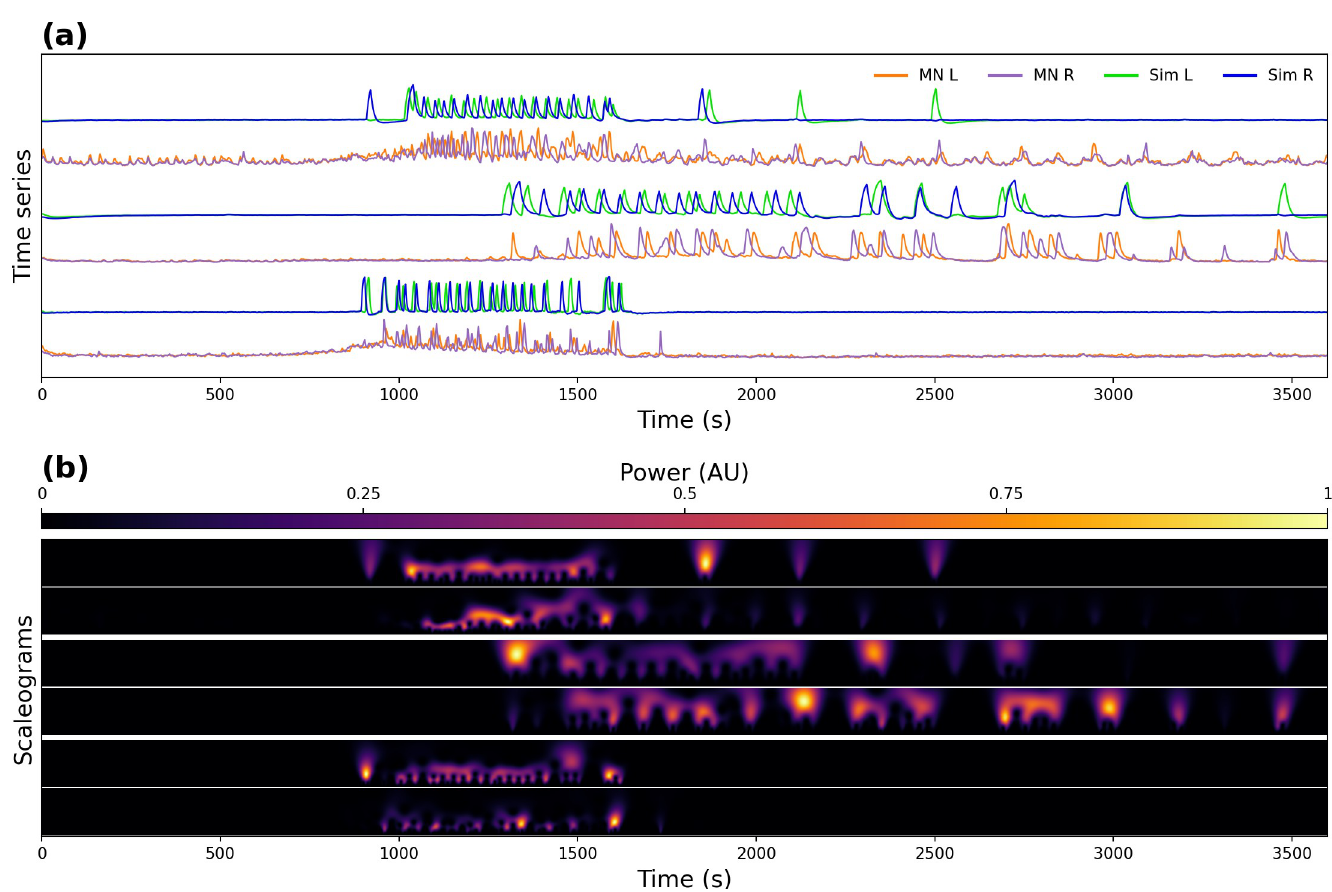
Fig 8. Simulations of the Logistic model linked to a conductance-based bursting model. (a) Experimental and simulated time series for 3 experiments. “MN L”, “MN R”, “Sim L” and “Sim R” indicate the left and right experimental, and left and right simulated motoneuron activity respectively. (b) Corresponding scaleograms, except that the scaleogram for the simulations is the average of 10 simulations. Each row shows the experimental (bottom) and the simulated (top) motoneuron activity, respectively.